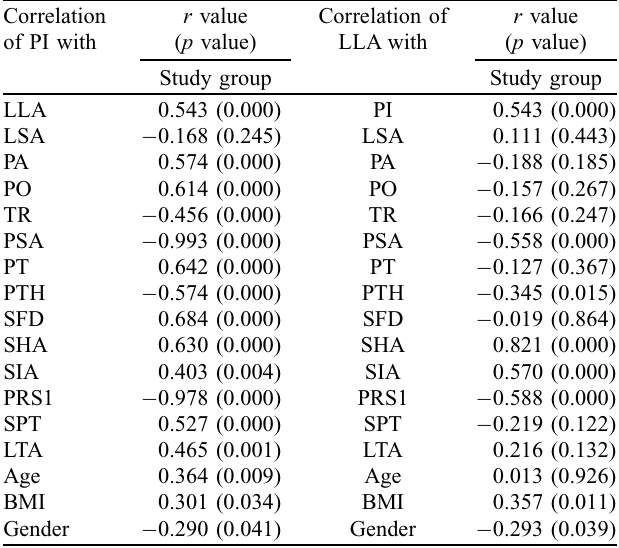
Table 4. Correlation of pelvic incidence and lumbar lordosis angle with other radiographic parameters, age, gender, and BMI.